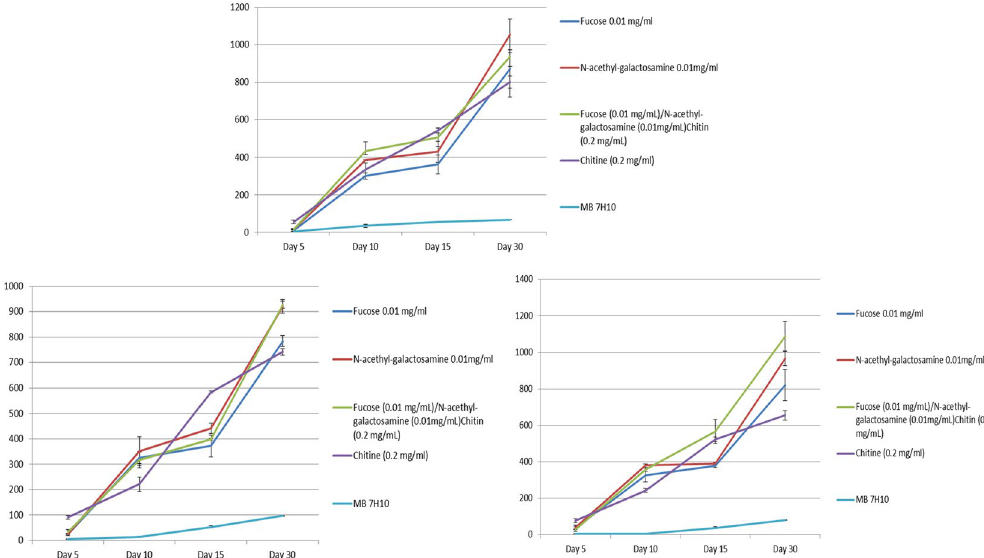
Figure 3. Improved growth of M. ulcerans strains (10 4 bacilli) by N-acetyl galactosamine (NAG) (0.01 mg/ mL), fucose (0.01 mg/mL), chitin (0.2 mg/mL) and DZ medium (NAG (0.01 mg/mL), fucose (0.01 mg/mL), chitin (0.2 mg/mL) versus growth onto Middlebrook 7H10 (p < 0.05). ( A ) M. ulcerans CU001; ( B ) M. ulcerans ATCC25900; ( C ) M. ulcerans ATCC33728.